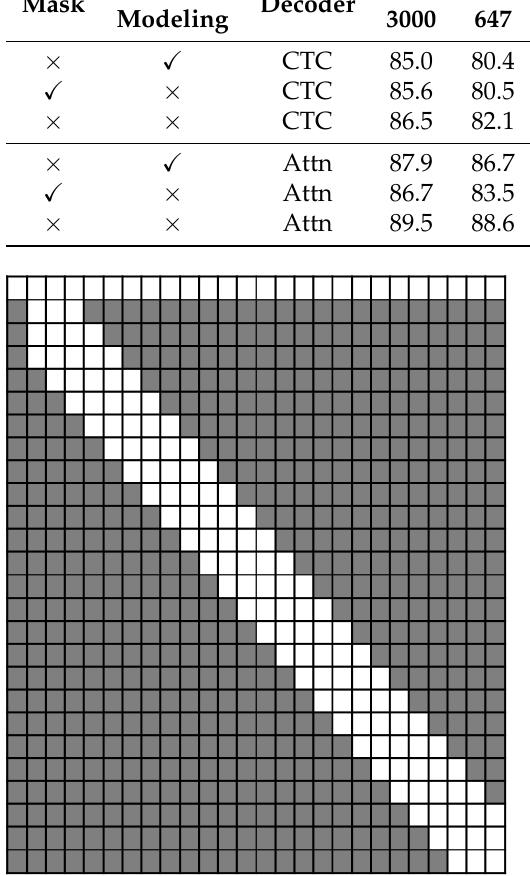
Figure 5. The detail of the mask used in the transformer encoder. The gray square denotes the mask. The first row means initial embedding which can see all embeddings. The remaining features can only see other features of the window